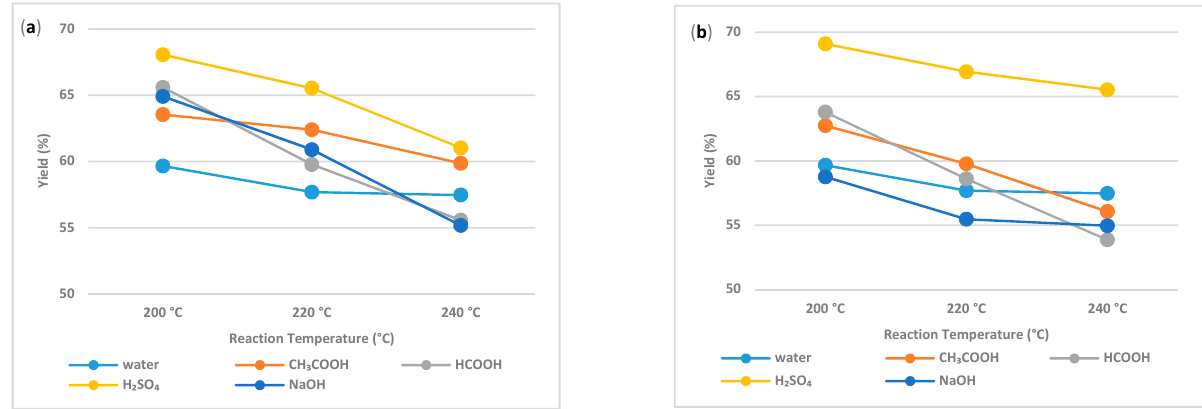
Figure 2. Influence of additives and temperature on yield of hydrochar; ( a ) represents the hydrochar yield produced using additives of 0.1 M concentration; ( b ) represents the hydrochar yield produced using additives of 0.25 M concentration.